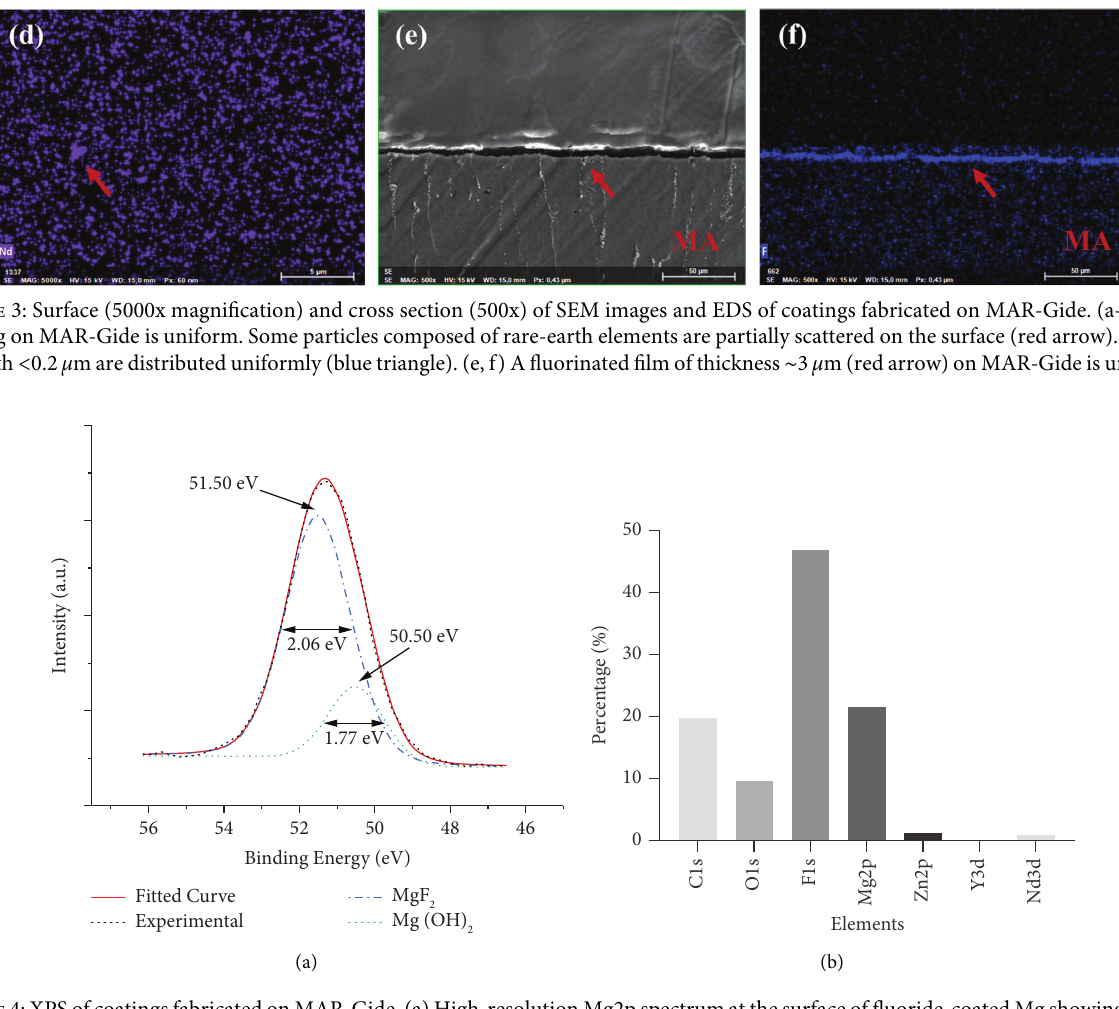
Figure 4: XPS of coatings fabricated on MAR-Gide. (a) High-resolution Mg2p spectrum at the surface of fluoride-coated Mg showing center and FWHM values for MgF 2 and Mg (OH) 2 . (b) Elemental composition of surface